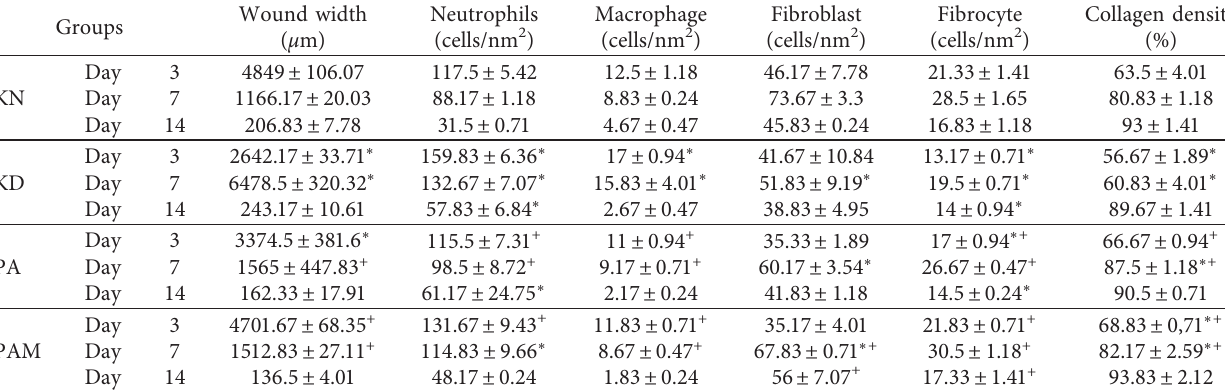
Table 1: Wound healing parameters on day 3, 7, and 14 of treatment.